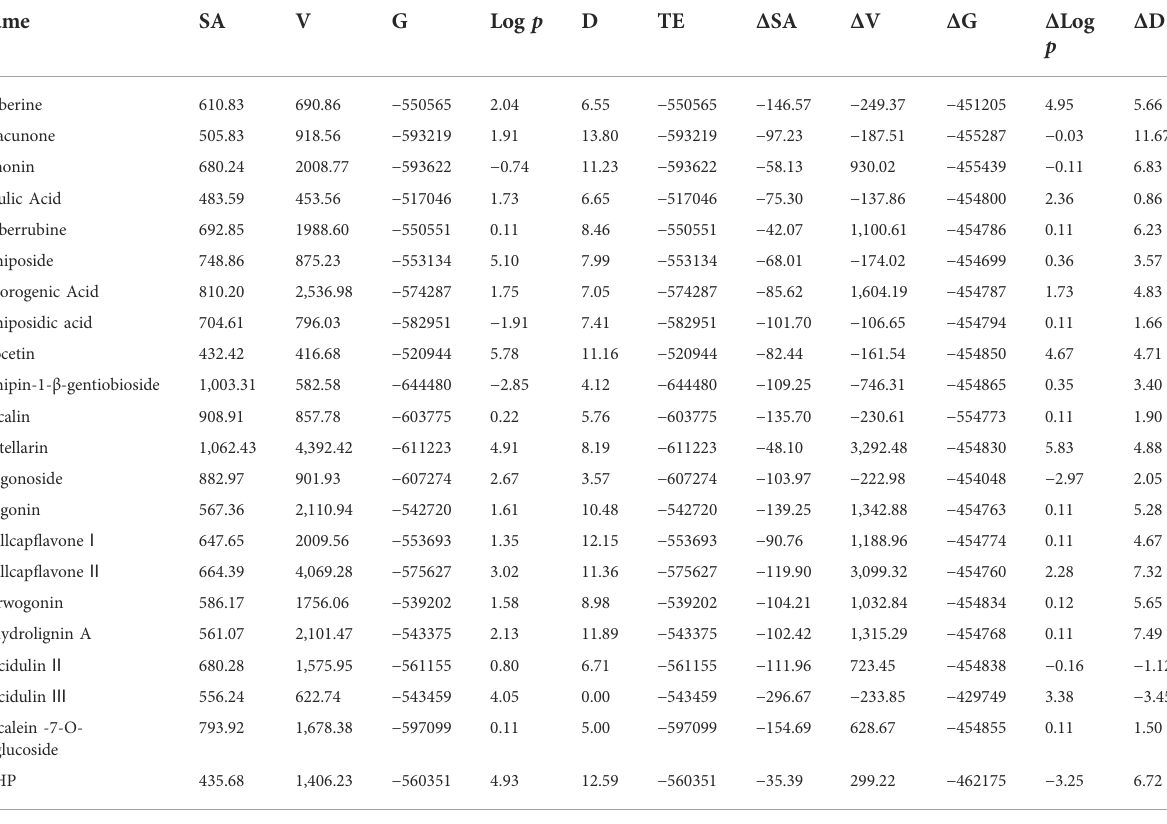
TABLE 6 Molecular parameters after self-assembly and the difference before and after self-assembly.